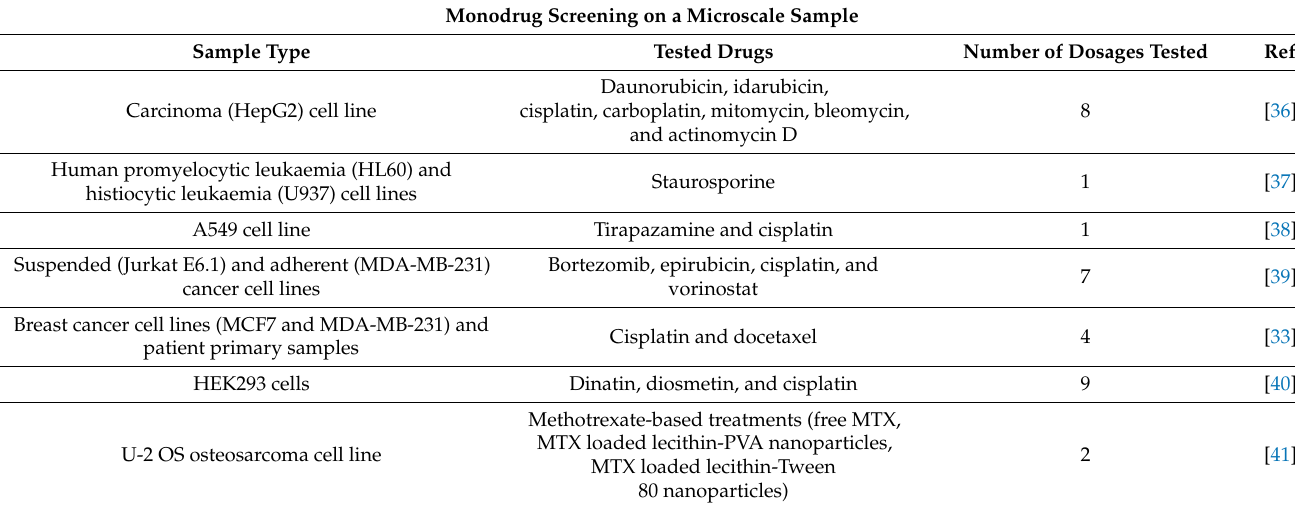
Table 1. Summarizes the presented drug screening platforms for cancer